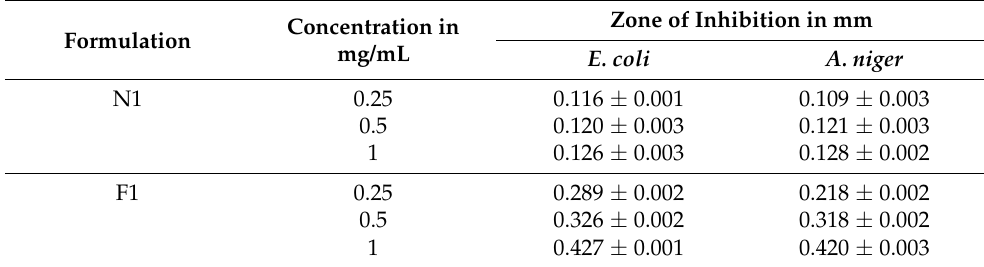
Table 3. Antimicrobial activity of native TSP (N1) and TSP-g-Am (F1). Formulation